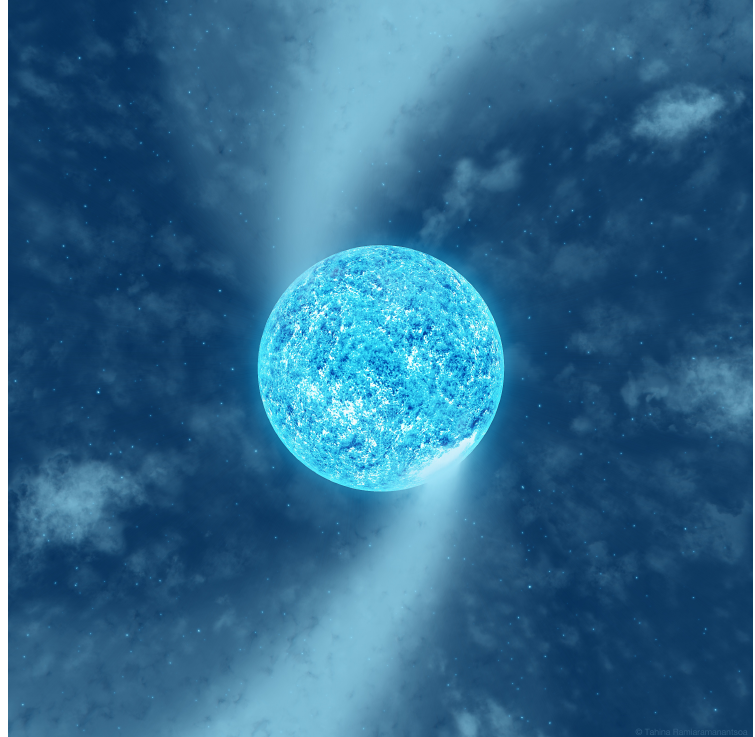
Figure 6. Artist’s drawing of ζ Pup with two large surface bright spots triggering CIRs in its wind (the potential flattening of the star due to its rapid rotation is not depicted). Image credit: Tahina Ramiaramanantsoa.